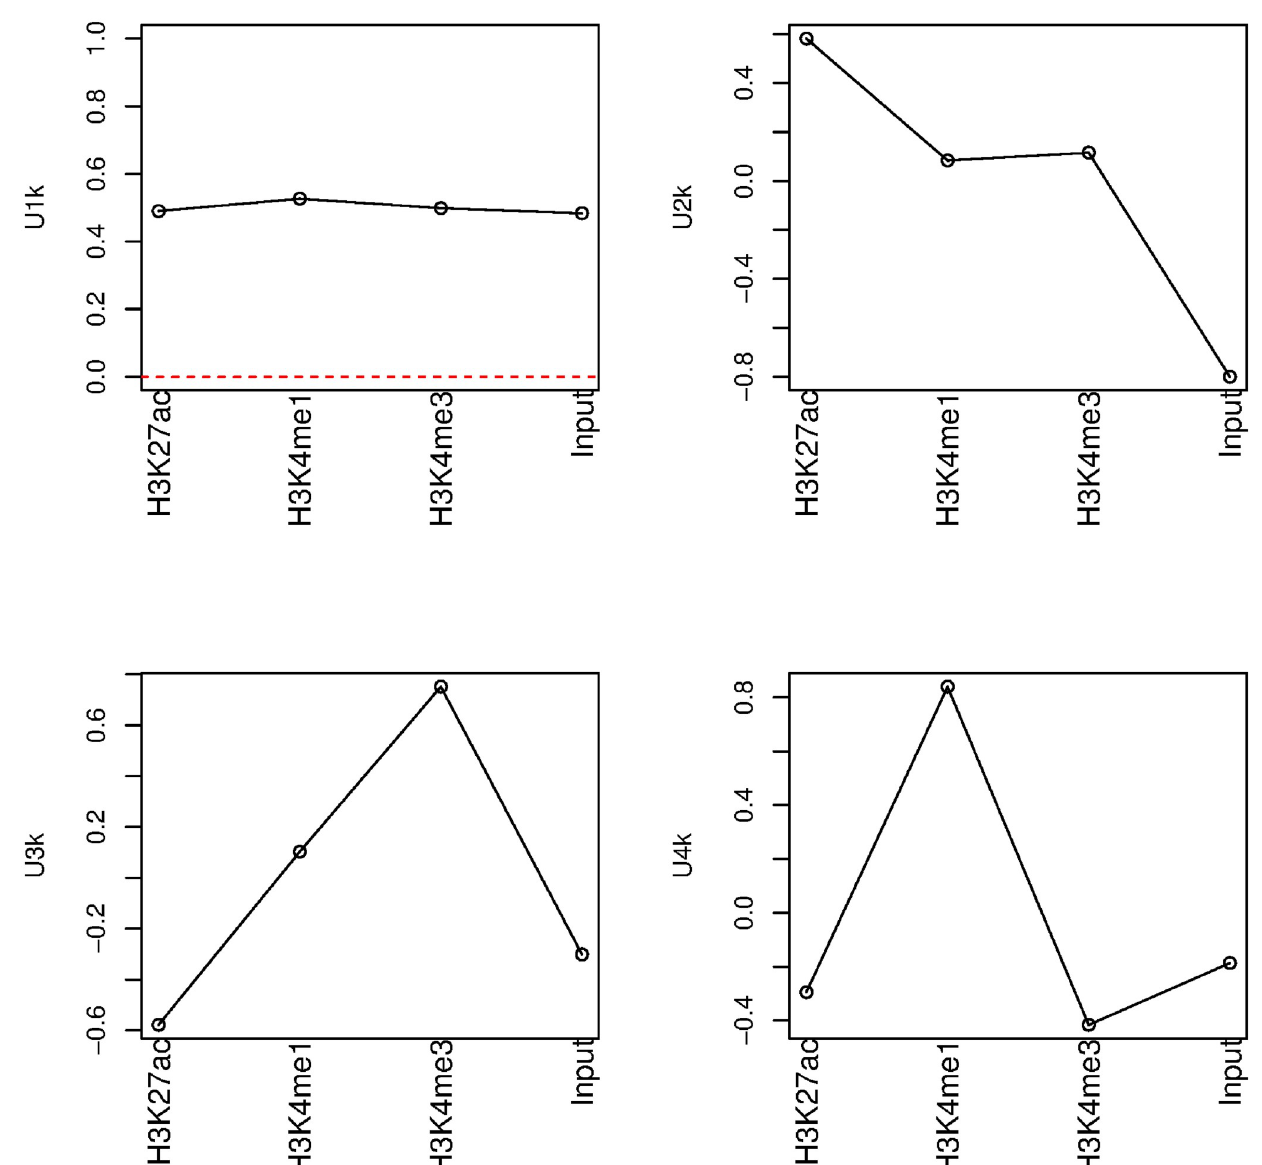
Fig 6. Singular-value vectors associated with histone modification. Upper left: u 1